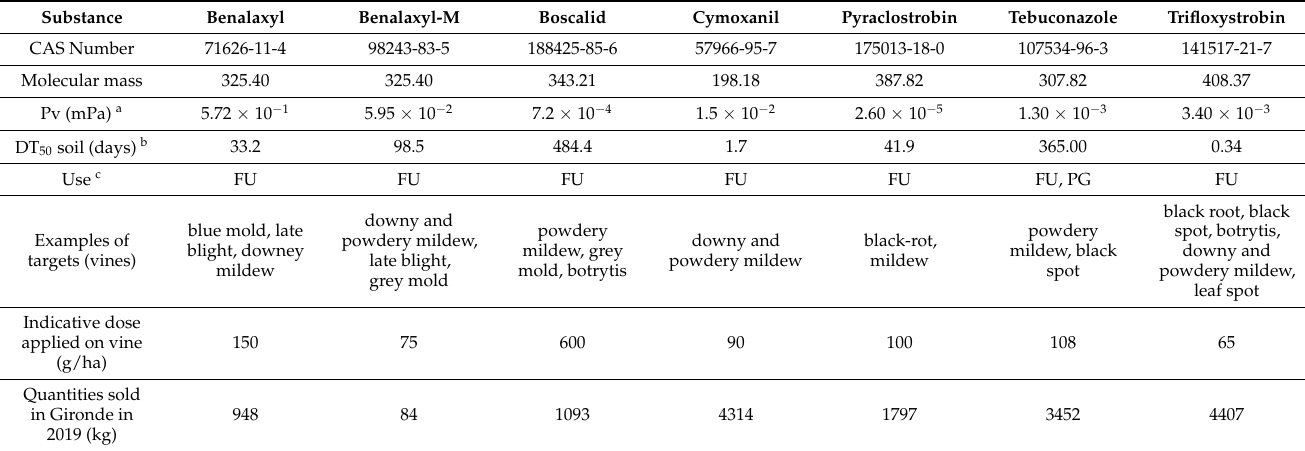
Table 1. Properties and uses of pesticides analyzed in the PESTIPREV pilot